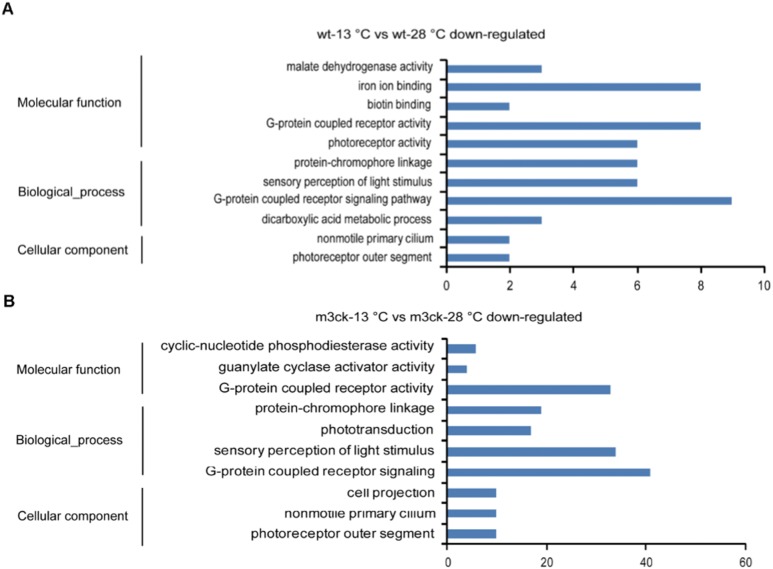
GO enrichment analysis of down-regulated transcripts of transgenic and wild-type fish under cold stress.A. wt-13°C vs. wt-28°C down-regulated transcripts. B. m3ck-13°C vs. m3ck-28°C down-regulated transcripts. The horizontal axis represents transcript count in each GO term. Down-regulated transcripts were submitted for GO enrichment analysis using the SAS online analysis system.